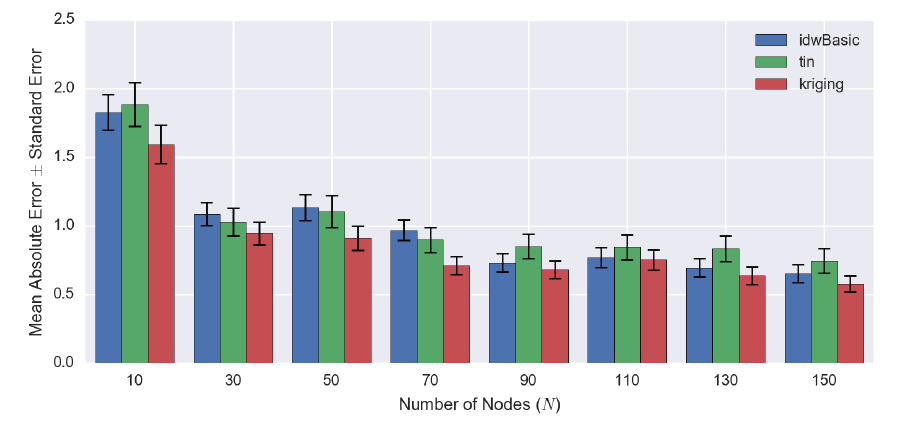
Figure 10. This graph demonstrates the MAE with the corresponding SE between the different 2D spatial interpolation techniques, using the data as shown in Table